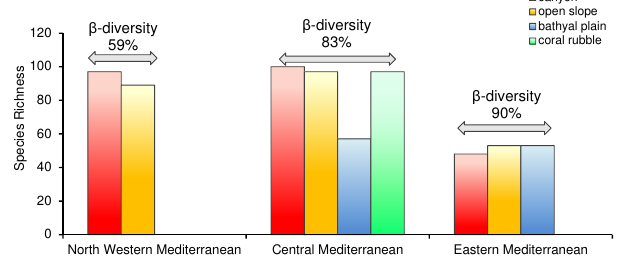
Fig. 2. Species richness of the nematodes in the different habitats in each of the regions investigated, calculated as number of cumu- lative species retrieved in each habitat. Mean β diversity among the habitats in each investigated region is also